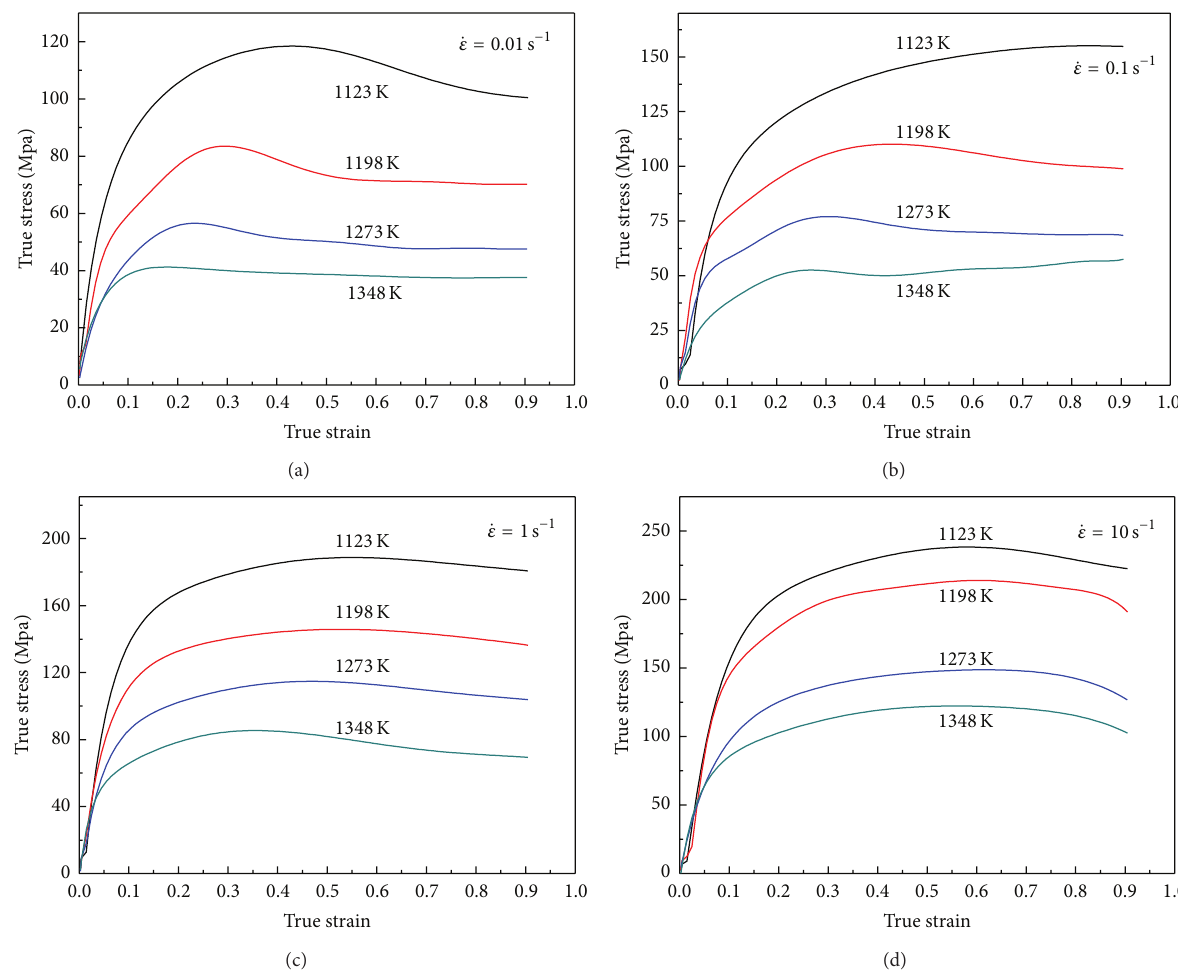
Figure 1: The true stress-strain curves of 42CrMo steel under the different deformation temperatures with strain rates (a) 0.01 s −1 , (b) 0.1 s −1 , (c) 1s −1 , and (d) 10s −1